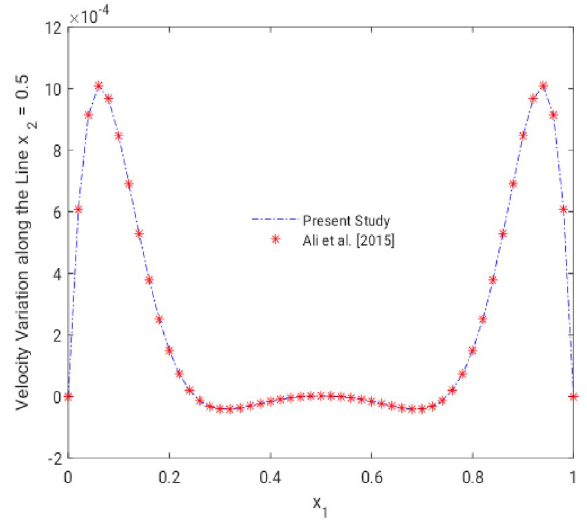
Figure 4. Comparison of present numerical results with scientific literature 8 .